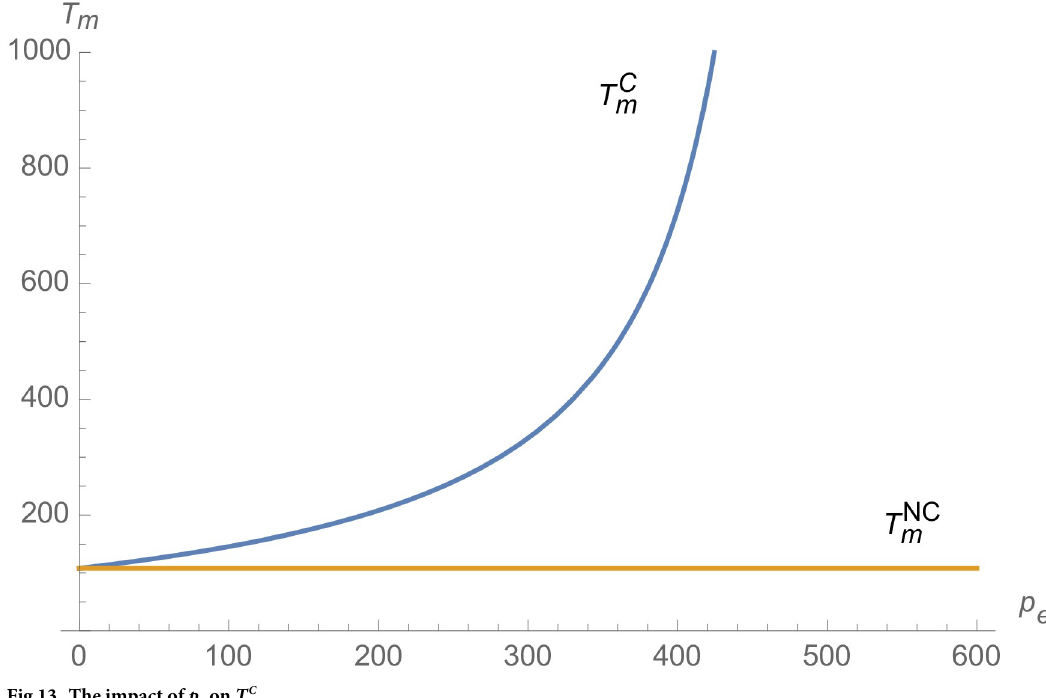
Fig 13. The impact of p e on T C